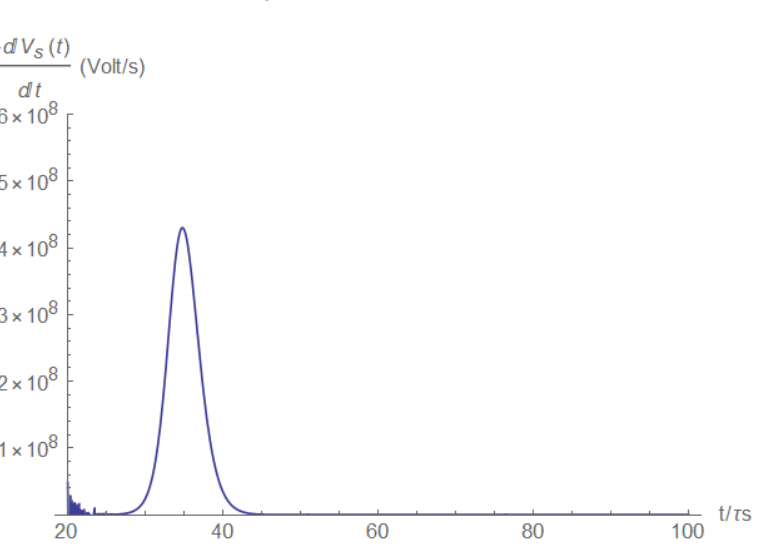
Figure A29. The short voltage.